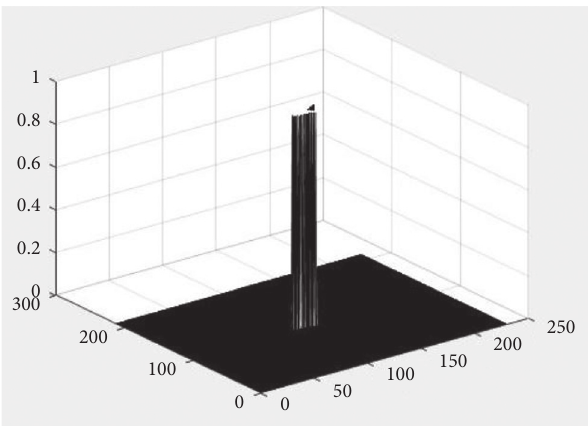
Figure 6: The voting results of the location of the center of the